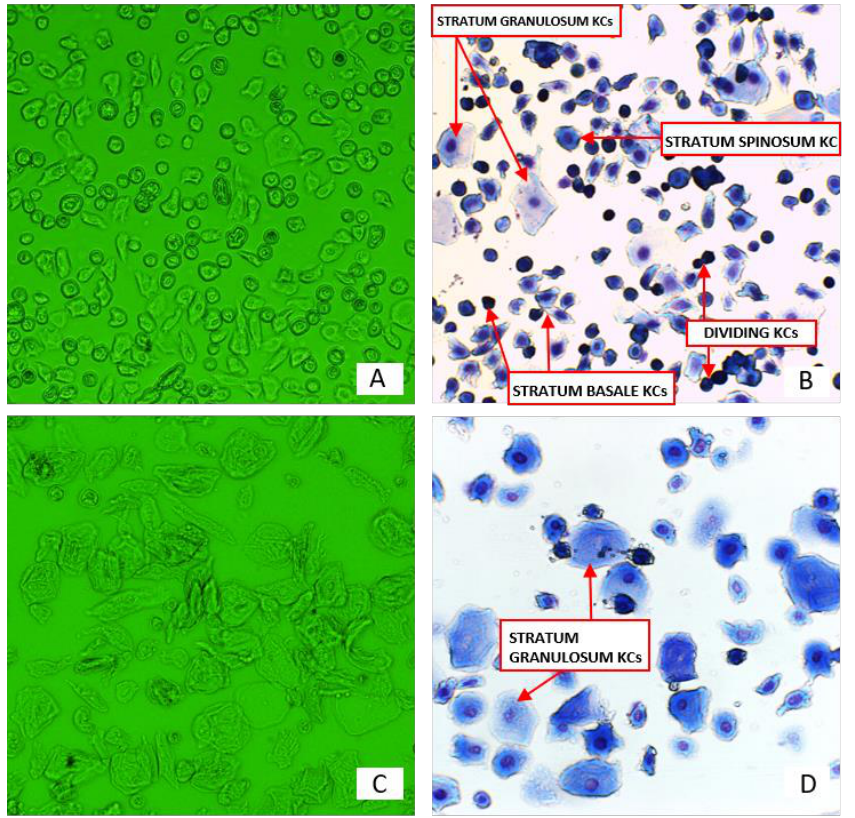
Figure 2. Keratinocytes isolated from skin preserved for 3 months ( A , B ) and from skin preserved for 6 months ( C , D ). ( A ) KCs culture, magnification 20×. ( B ) MGG staining, magnification 20×. ( C ) KCs culture, magnification 40×. ( D ) MGG staining, magnification 40×.